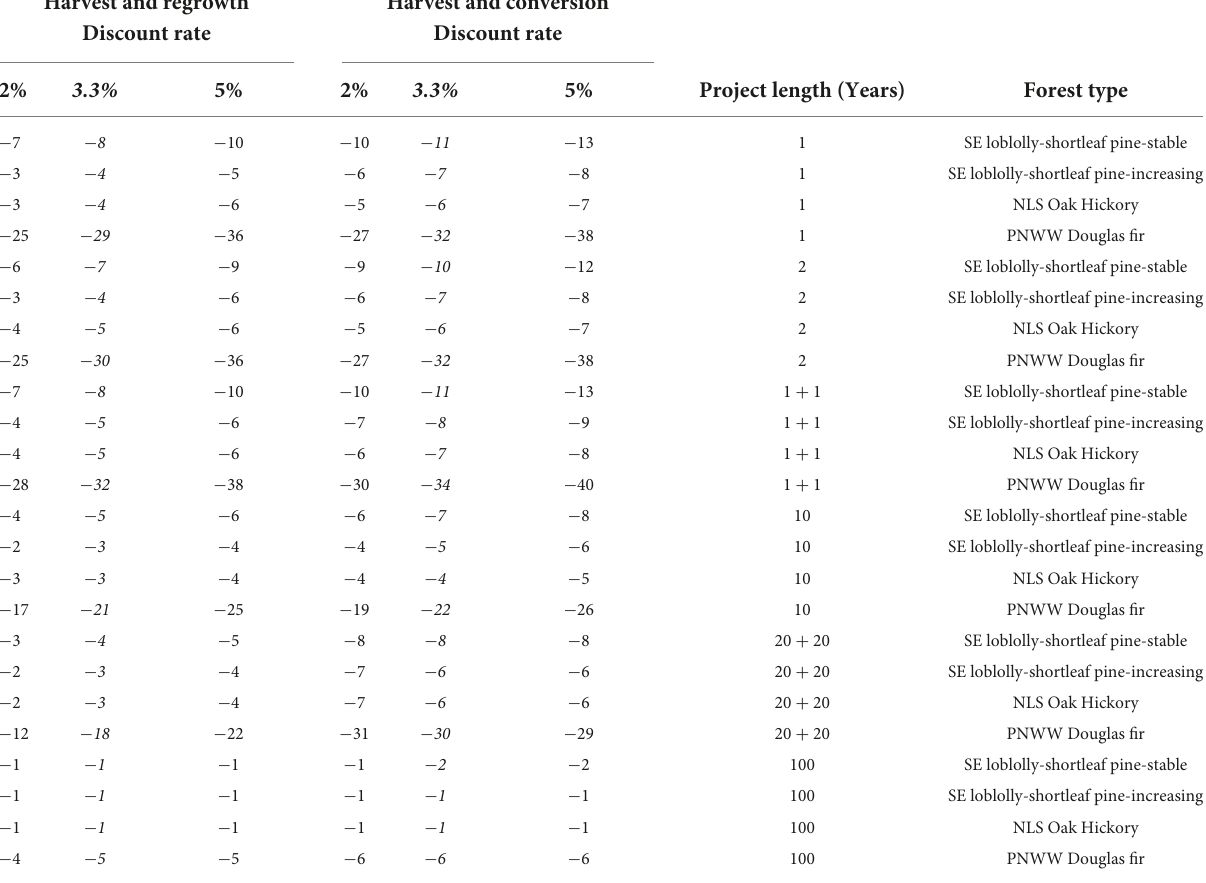
TABLE 3 Sensitivity analysis for discounted decay accounting, showing values of average annual net carbon flux (tC/ha) varying by assumed discount rate. Harvest and